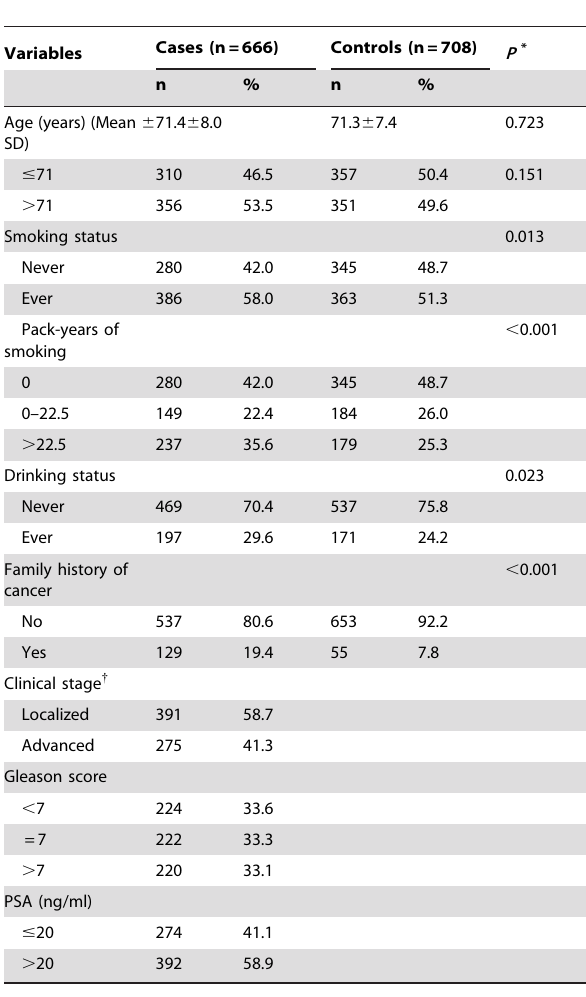
*T-test for age distributions between the cases and controls; two-sided x 2 test for others selected variables between the cases and